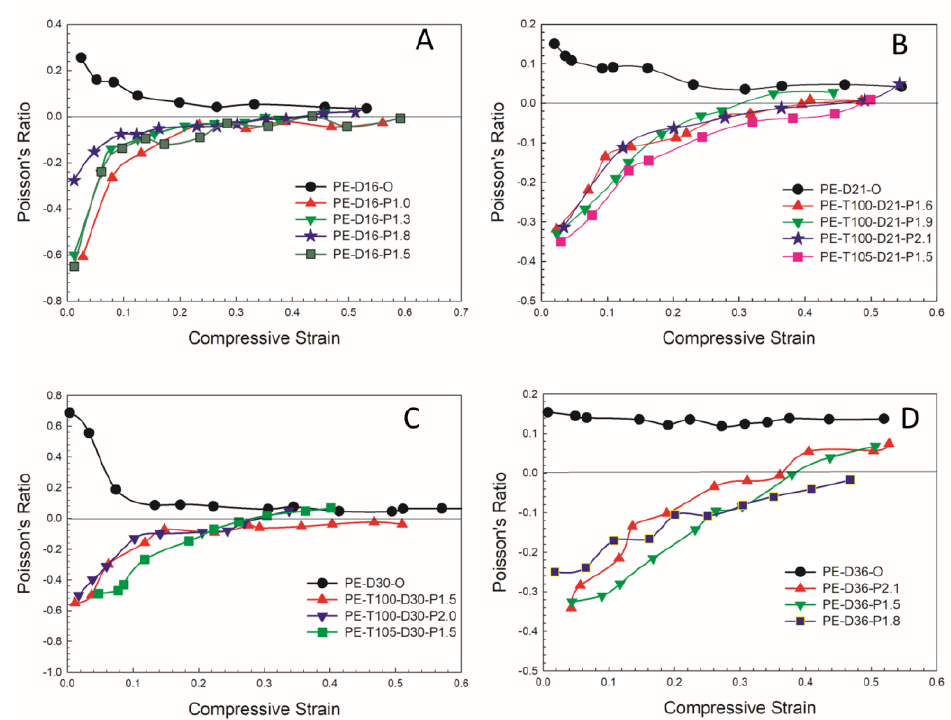
Figure 6. Poisson’s ratio as a function of compressive engineering strain for auxetic foams produced under different conditions (temperature and mechanical compression) with their initial foams based on ( A ) D16, ( B ) D21, ( C ) D30 and ( D )